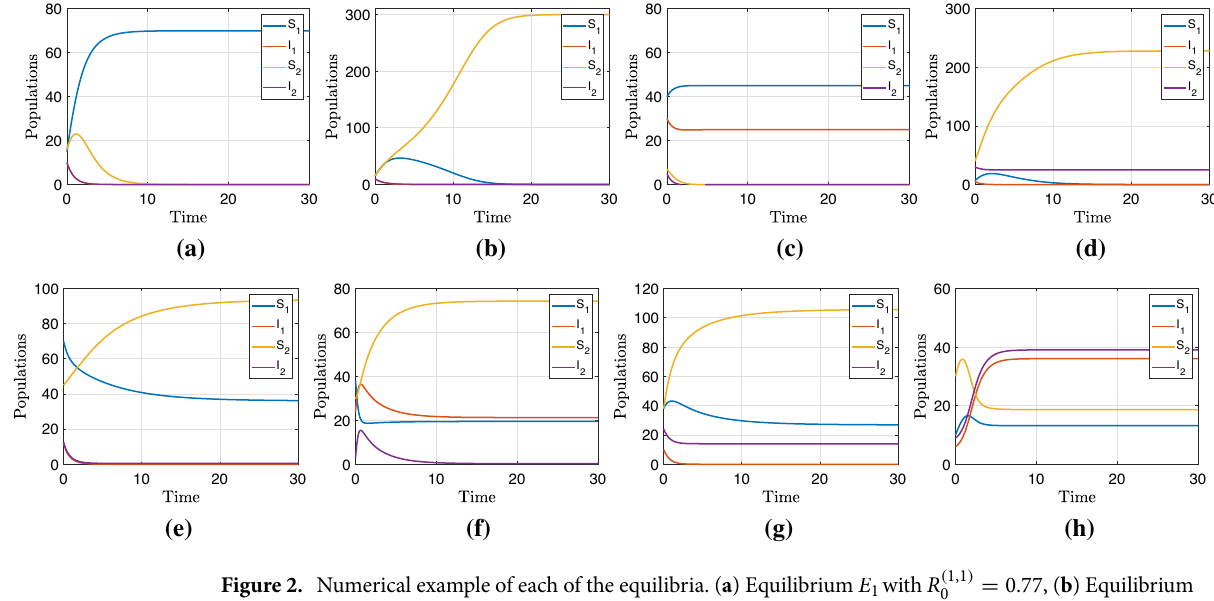
( 1,1 ) 0.77 , ( b ) Equilibrium 0 =